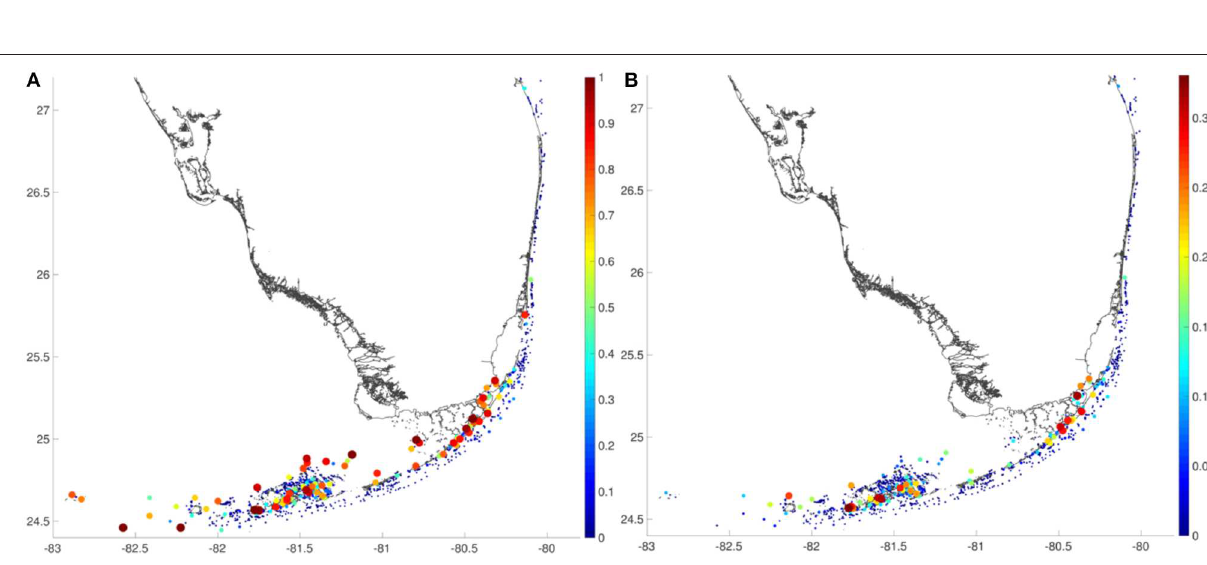
FIGURE 2 | The connectivity graph highlights the exchange of coral larvae between all the reefs of the FRT. The color code, from blue to red, indicates the strength of connections (i.e., the number of larvae exchanged). The graph suggests that connectivity can occur over the entire length of the FRT as reefs around Key West and the Marquesas Keys are connected to reefs offshore of St. Lucy Inlet. The Dry Tortugas however appear to be isolated from the rest of the FRT.